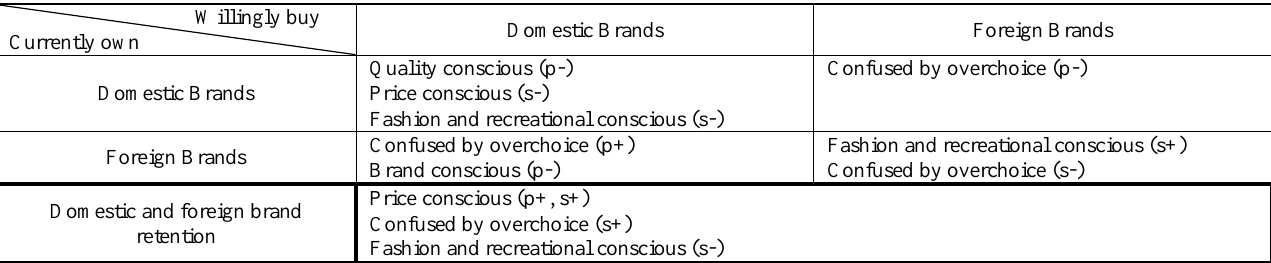
Table 6: Summary of influence of decision-making styles on switching intention Willingly buy Domestic Brands Foreign Brands Currently own Quality conscious (p-) Domestic Brands Price conscious (s-) Fashion and recreational conscious